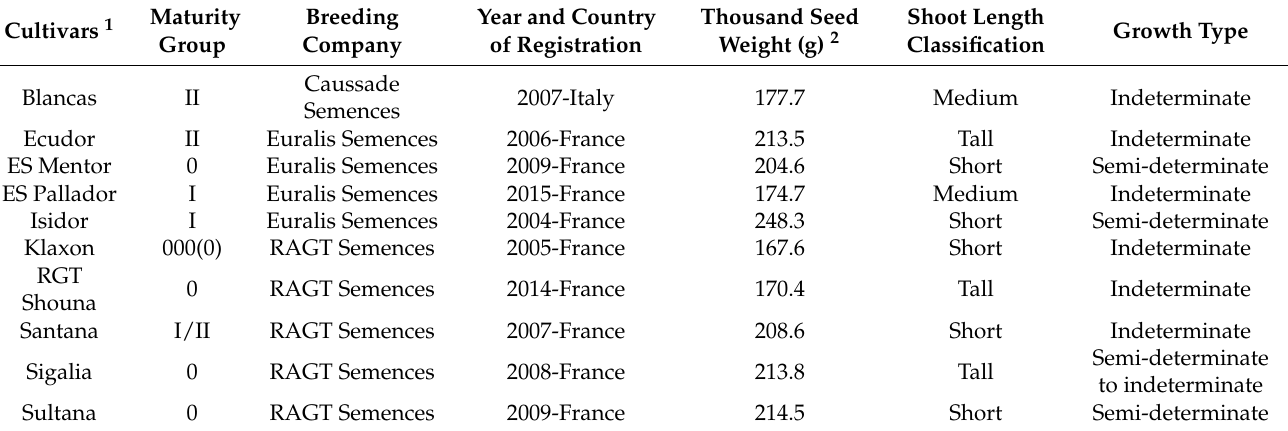
Table 1. Main characteristics of the soybean cultivars used in this study.